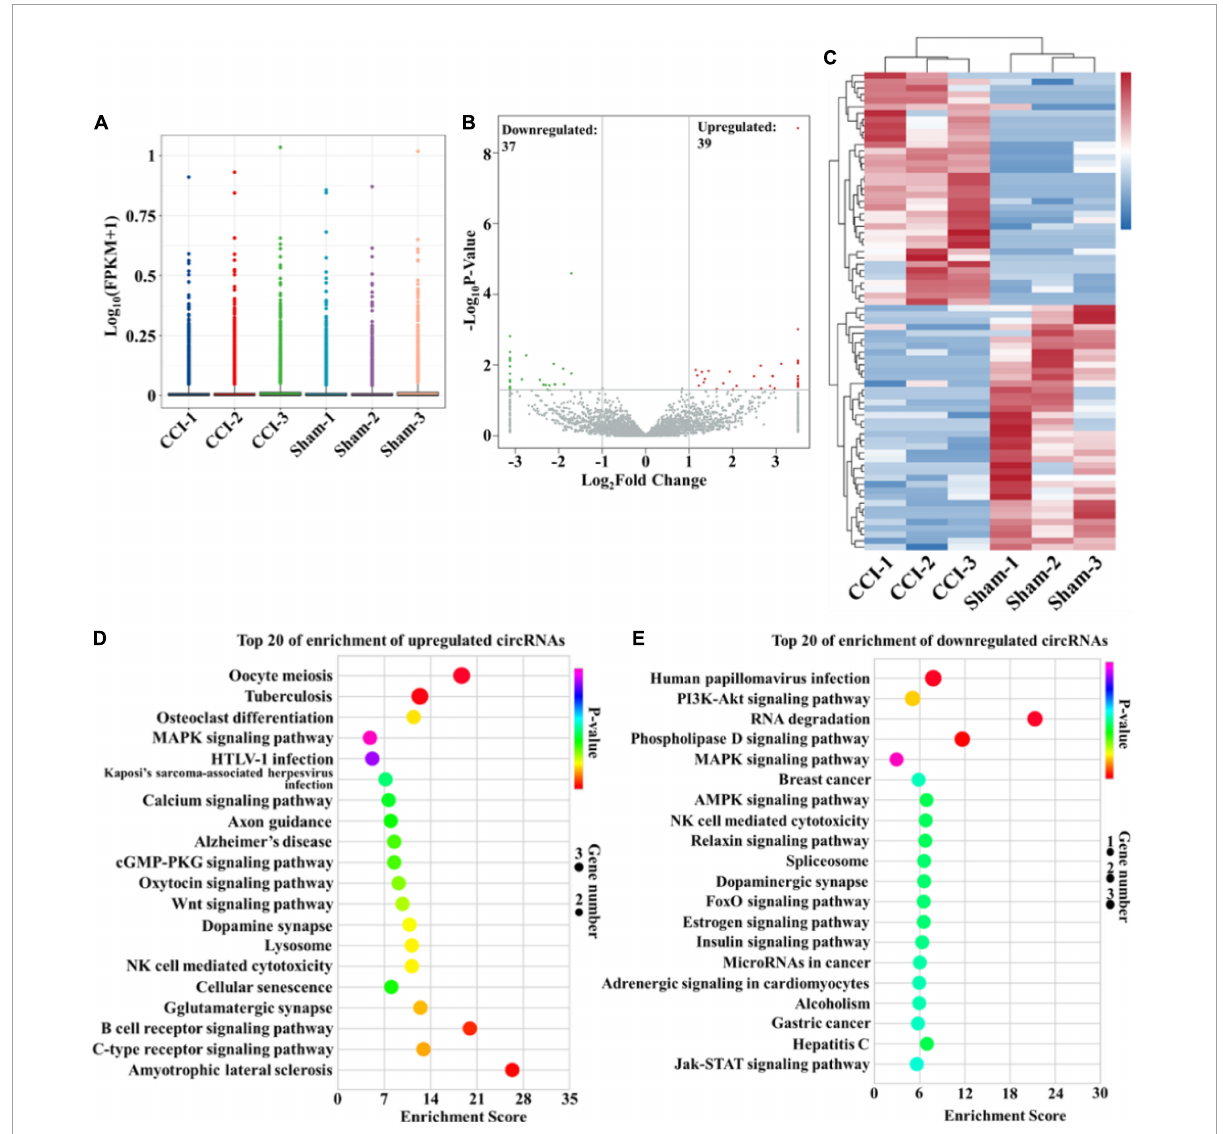
FIGURE2 Bioinformatic analysis of differentially expressed circRNAs in the hippocampus after CCI. (A) Box-whisker plot showing the symmetry and distribution of data. Statistical analysis was conducted based on the minimum, first quartile (25%), median (50%), third quartile (75%), and maximum. (B) Volcano plots displaying the differentially expressed circRNAs with | log2(fold change)| > 1 and P -value < 0.05. Statistical analysis was conducted via a negative binomial distribution test. (C) Hierarchical clustering plot displaying the differentially expressed circRNA profile in the hippocampus after CCI. (D,E) KEGG pathway analysis showed the top 20 significantly enriched pathways and their scores for the upregulated and downregulated circRNAs. Statistical analysis was conducted via a hypergeometric